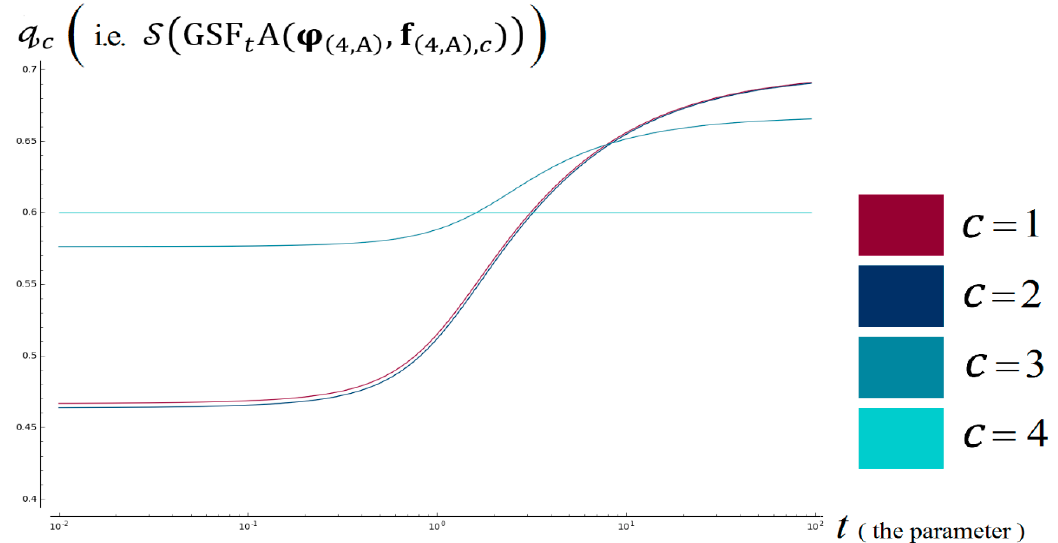
Figure 7. The results of our algorithms GSF 𝑡 A and GSF 𝑡 A for compliance of t-dependence test of type-A.